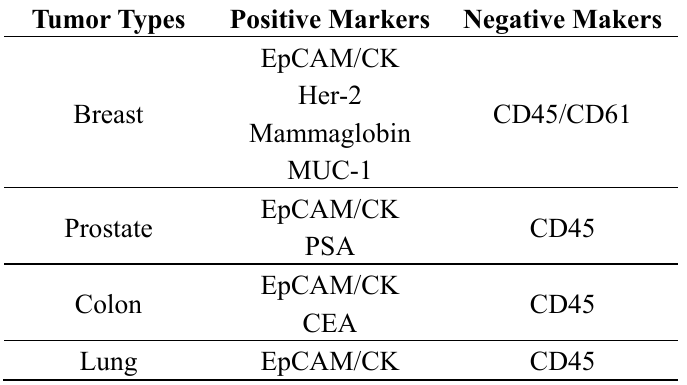
Table 2. Positive/negative markers for enrichment and detection of CTCs in different tumor